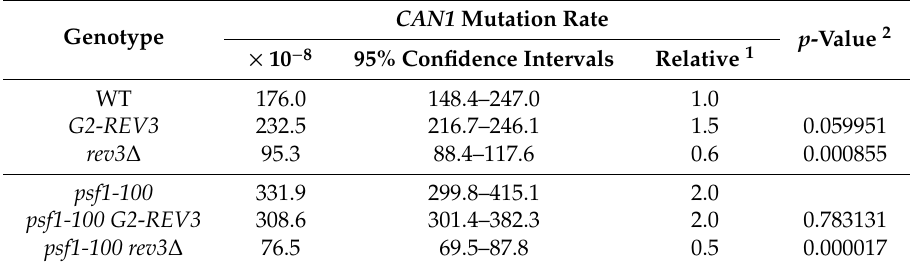
Table 1. Spontaneous mutagenesis rates in psf1-100 cells with G2-REV3